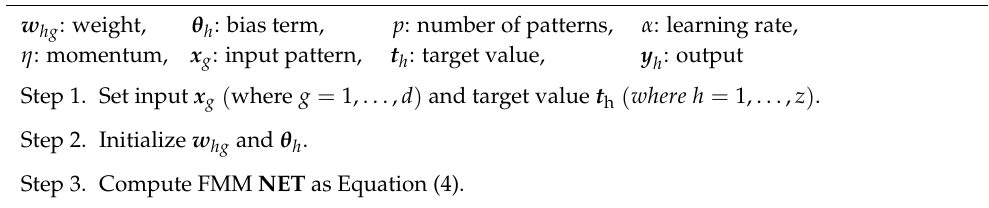
Algorithm 2. Fuzzy max–min neural network learning